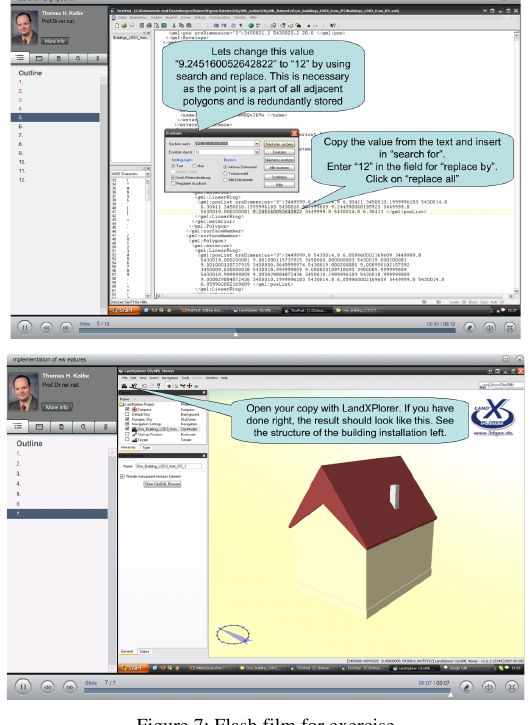
Figure 7: Flash film for